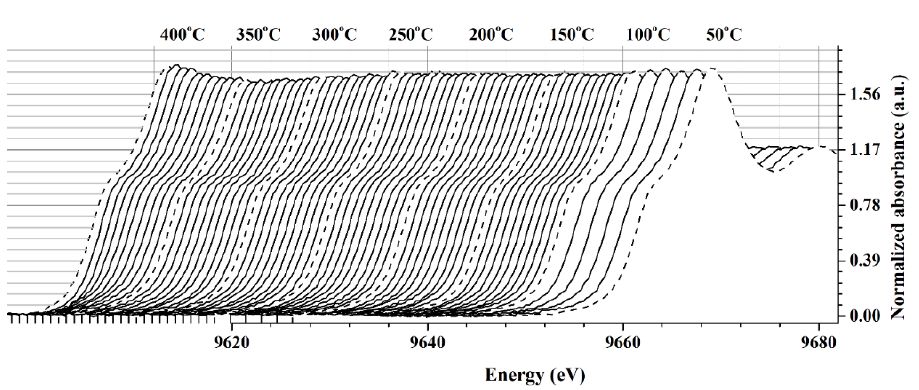
Figure 4. The normalized Zn K-edge XANES of ZnO film under the CH 4 atmosphere and applied temperature.